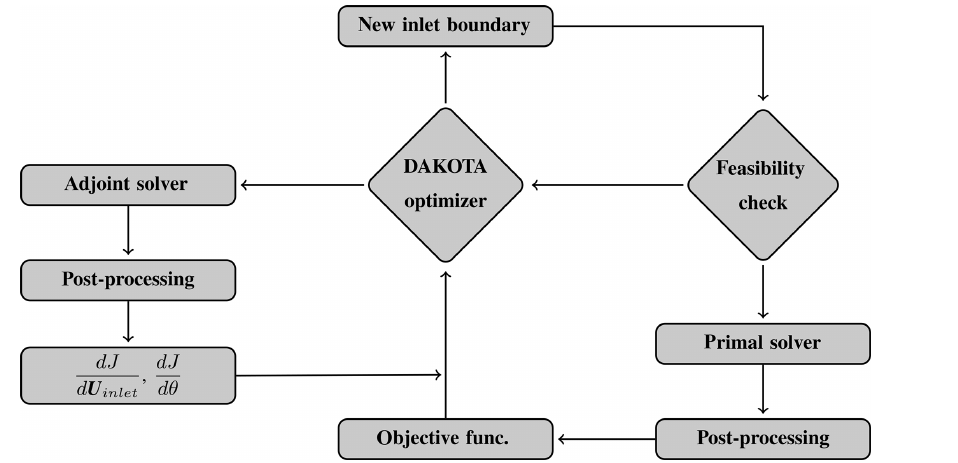
Figure 5. The calibration flowchart of the inflow boundary using the DAKOTA optimization package and the developed adjoint solver.